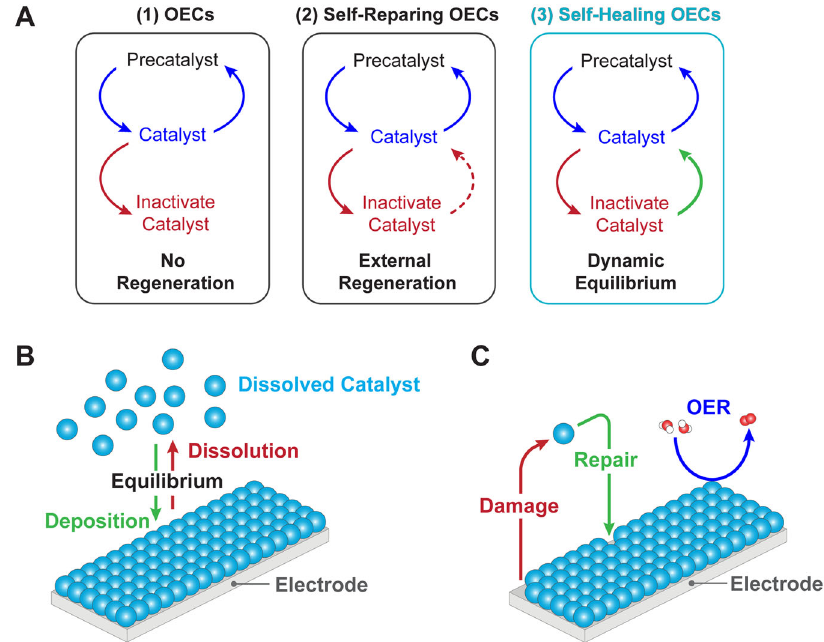
Fig. 1 Schematic depiction of self-healing OECs. A Self-repairing OECs (center) are a speci fi c type of OECs (left) that may operate for a prolonged time as they are regenerated once they become inactive, usually with the aid of an external input (e.g., energy, pressure, chemical healing agents). Self-healing OECs (right) are a speci fi c type of OECs that continually regenerate themselves through an equilibrium process that occurs under the operating conditions of OER. B Graphical representation of the competing effects of catalyst deposition and dissolution that give rise to the equilibrium implicit for self-healing OECs. C Based on the equilibrium shown in ( B ), a damaged site is continuously repaired during OER for self-healing OECs, and as the rate of repair is greater than or equal to the rate of damage, no loss of catalytic species is observed. Blue spheres represent a catalytically competent metal capable of self-healing (e.g., Mn, Co, Ni,